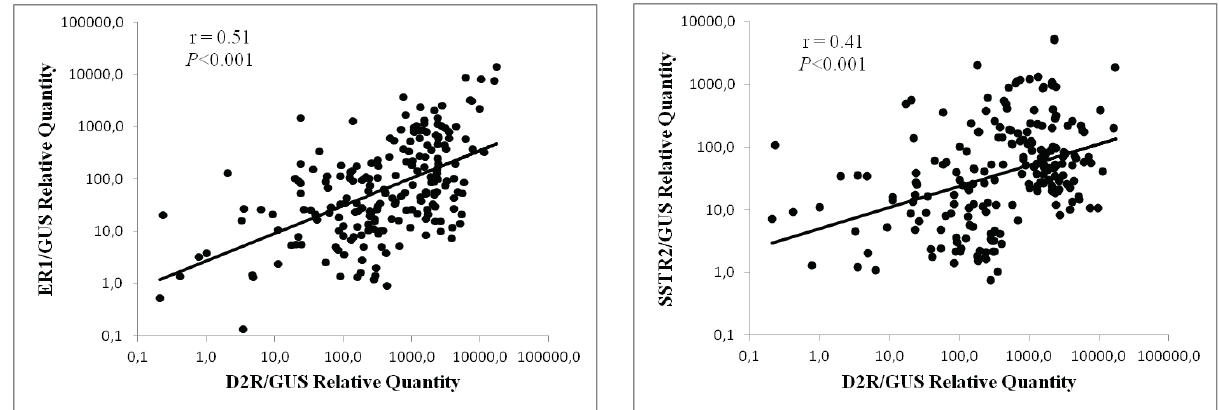
Fig. 2. Co-expressions of ER1 and D2R (left part) and SSTR2 and D2R (right part) genes in PA drawn in the logarithmic